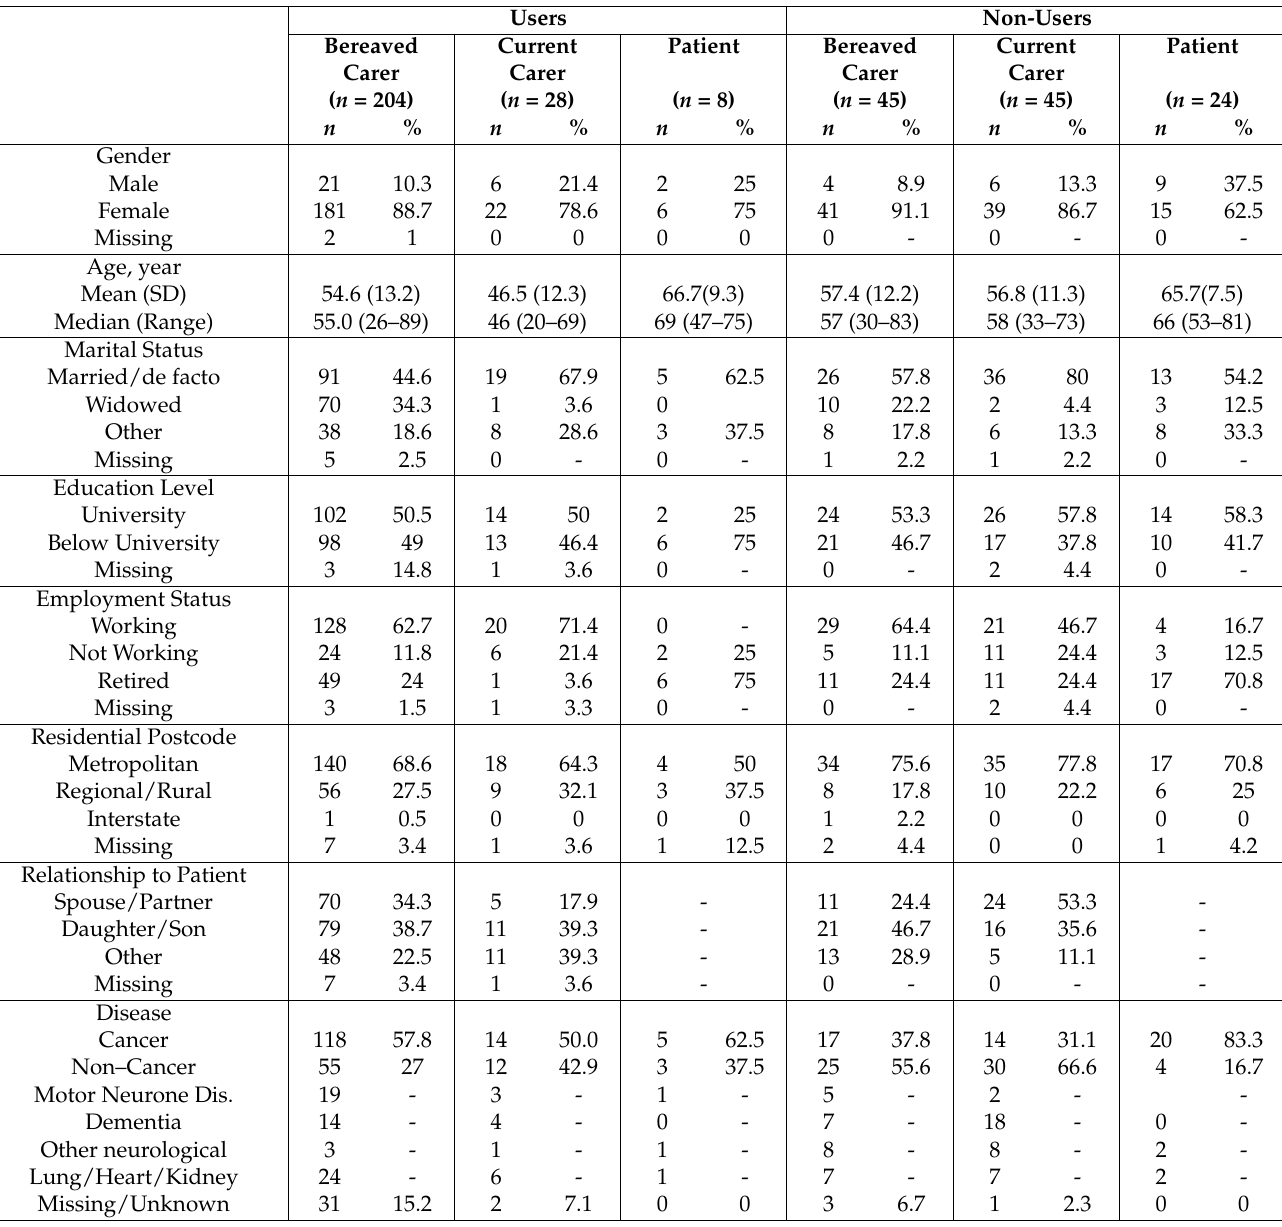
Table 2. Demographic characteristics of survey